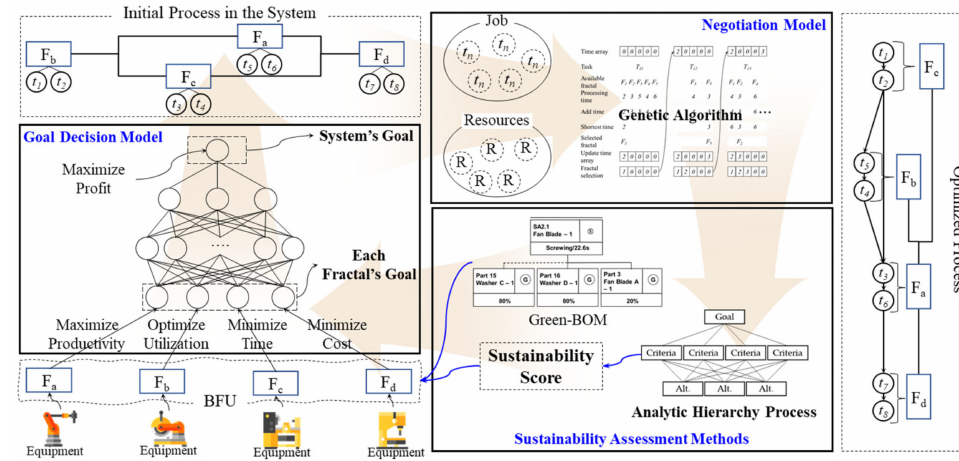
Figure 21. Process reconfiguration with the proposed methods in SSrMS